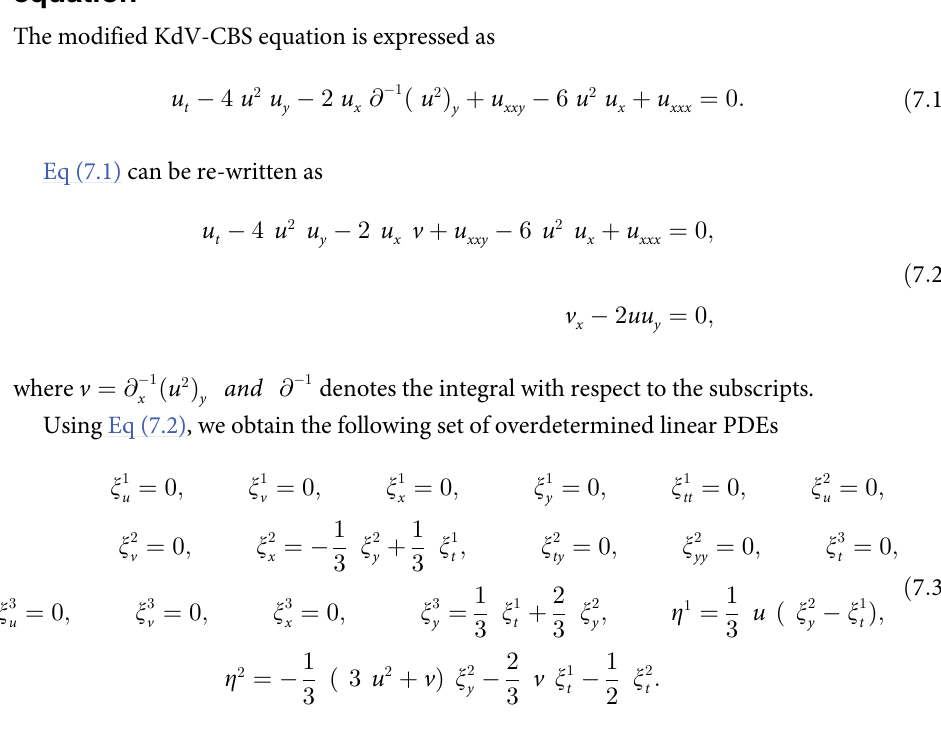
ffiffiffiffiffiffiffiffiffiffiffiffiffiffiffiffiffiffiffiffiffiffiffiffiffiffiffiffiffiffiffiffi (cid:0) a b (cid:0) 4 c